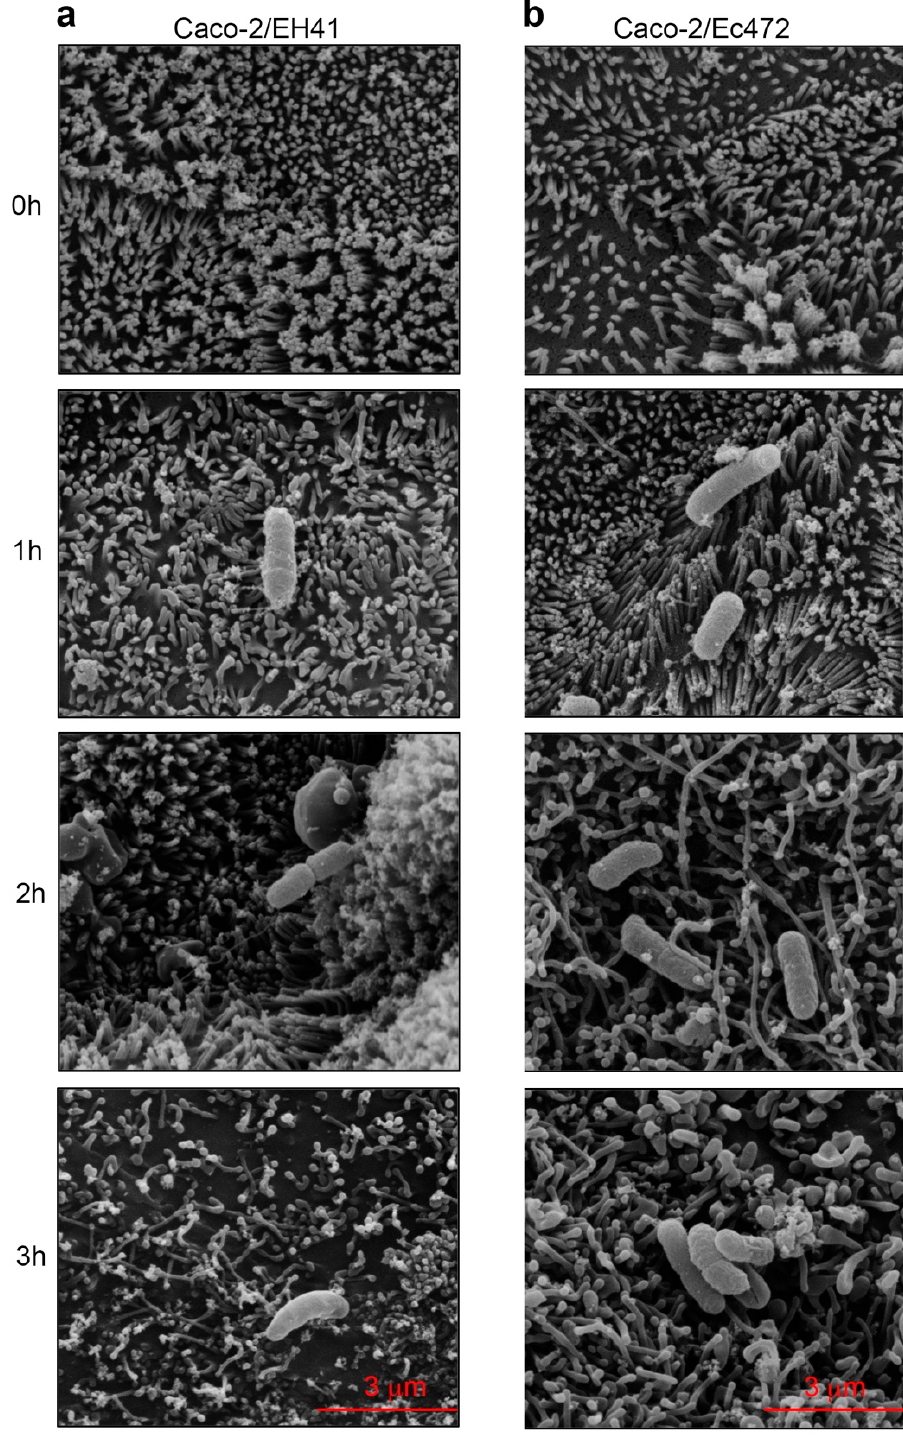
Figure 8. Serial SEM images of Caco-2-STEC interaction. Time series of STEC strains EH41 ( a ) and Ec472 ( b ) interaction with Caco-2 cells (Caco-2 / EH41 and Caco-2 / Ec472, respectively) at 0 h and three sequential intervals of 1 h each. Bacteria adhered to the cells were observed after 1 h of exposure. In the interval 1–3 h, EH41 caused progressive loss of microvilli. After 1 h, Ec472 also caused morphological changes of the cells, which were characterized by a decrease in microvilli number and their elongation from 2 h to 3 h.